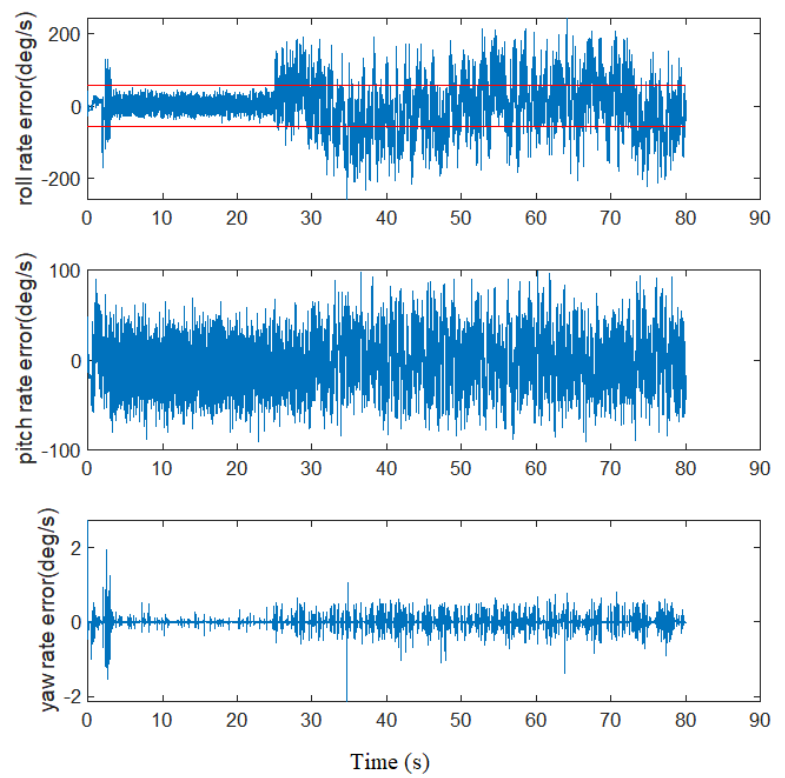
Figure 22. Multiplication fault: fault detection result (red line–threshold, blue line–residual).